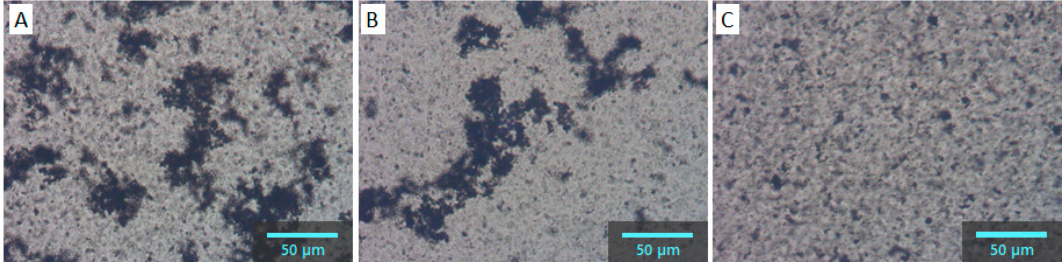
Figure 3. Optical microscopic images of ( A ) CB/NMP, ( B ) CB/PVDF/NMP ( C ) CB/PVP/NMP mixtures with 0.1 wt% of CB and 0.08 wt% of polymers.